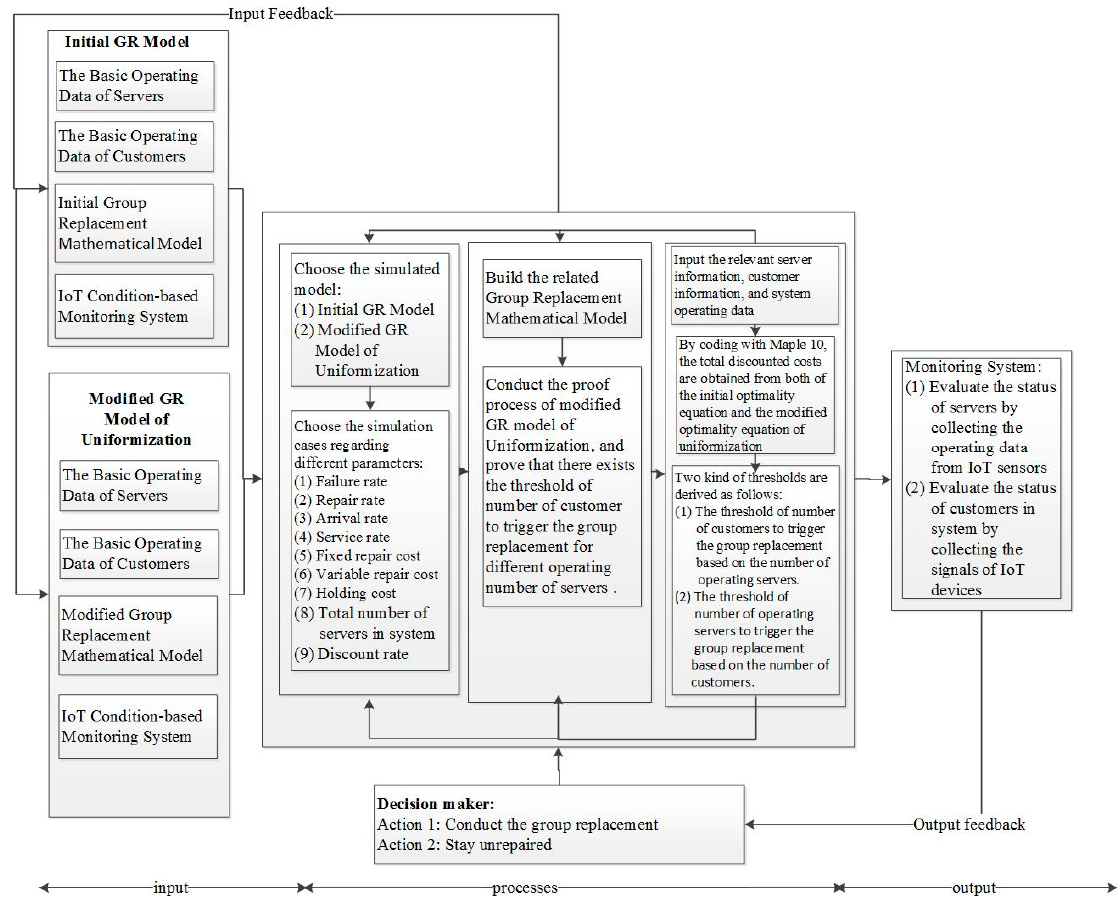
Figure 2. The procedure flow of decision support system.